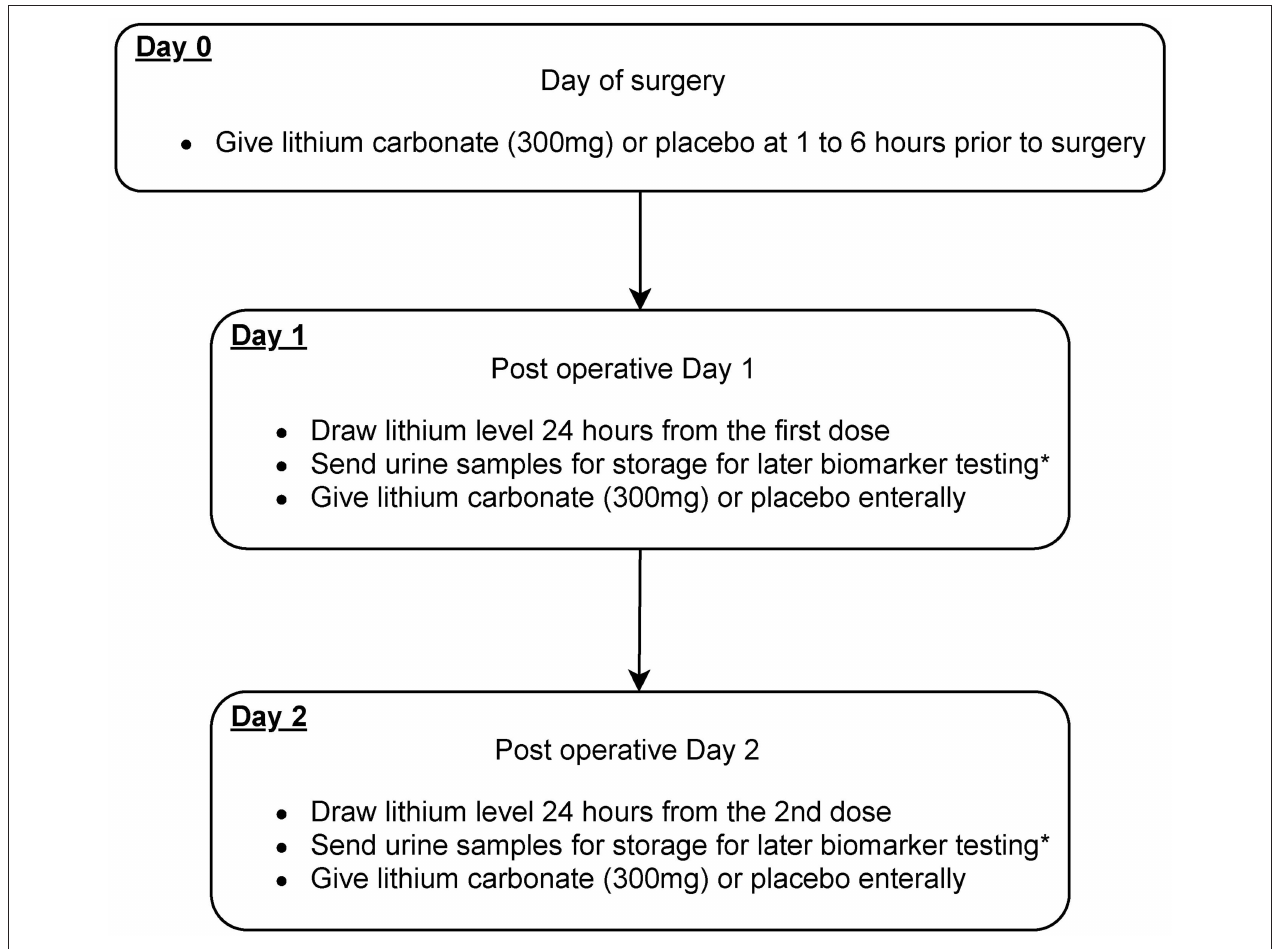
FIGURE 3 | Scheme diagram depicting study interventions to be given in this trial. Patients will receive microdose lithium carbonate or placebo treatment on day 0, 1, and 2 after the cardiovascular surgery. *Biomarkers that will be sent include urinary NGAL, KIM1, tissue inhibitor of metalloproteinases-2 (TIMP-2), and insulin-like growth factor-binding protein 7